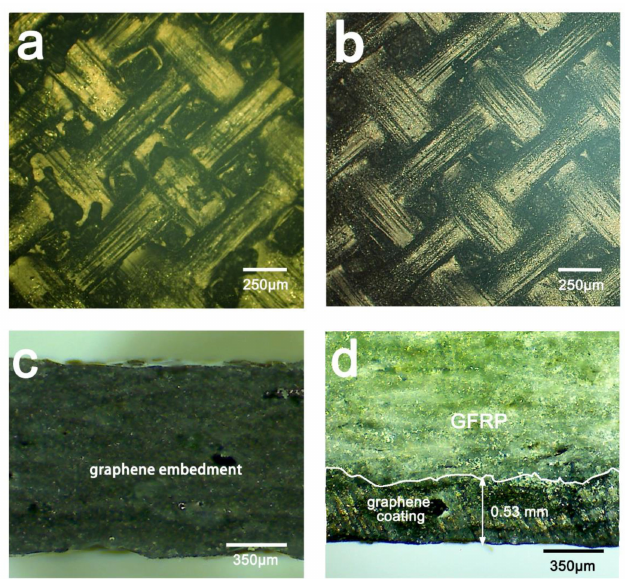
Figure 2. Optical images of glass fiber-reinforced polymer (GFRP) composite laminate with graphene preparation: ( a , b ) Surface morphology and ( c , d ) cross-section of samples with graphene embedded in interlayer ( a , c ) and coating ( b , d ).